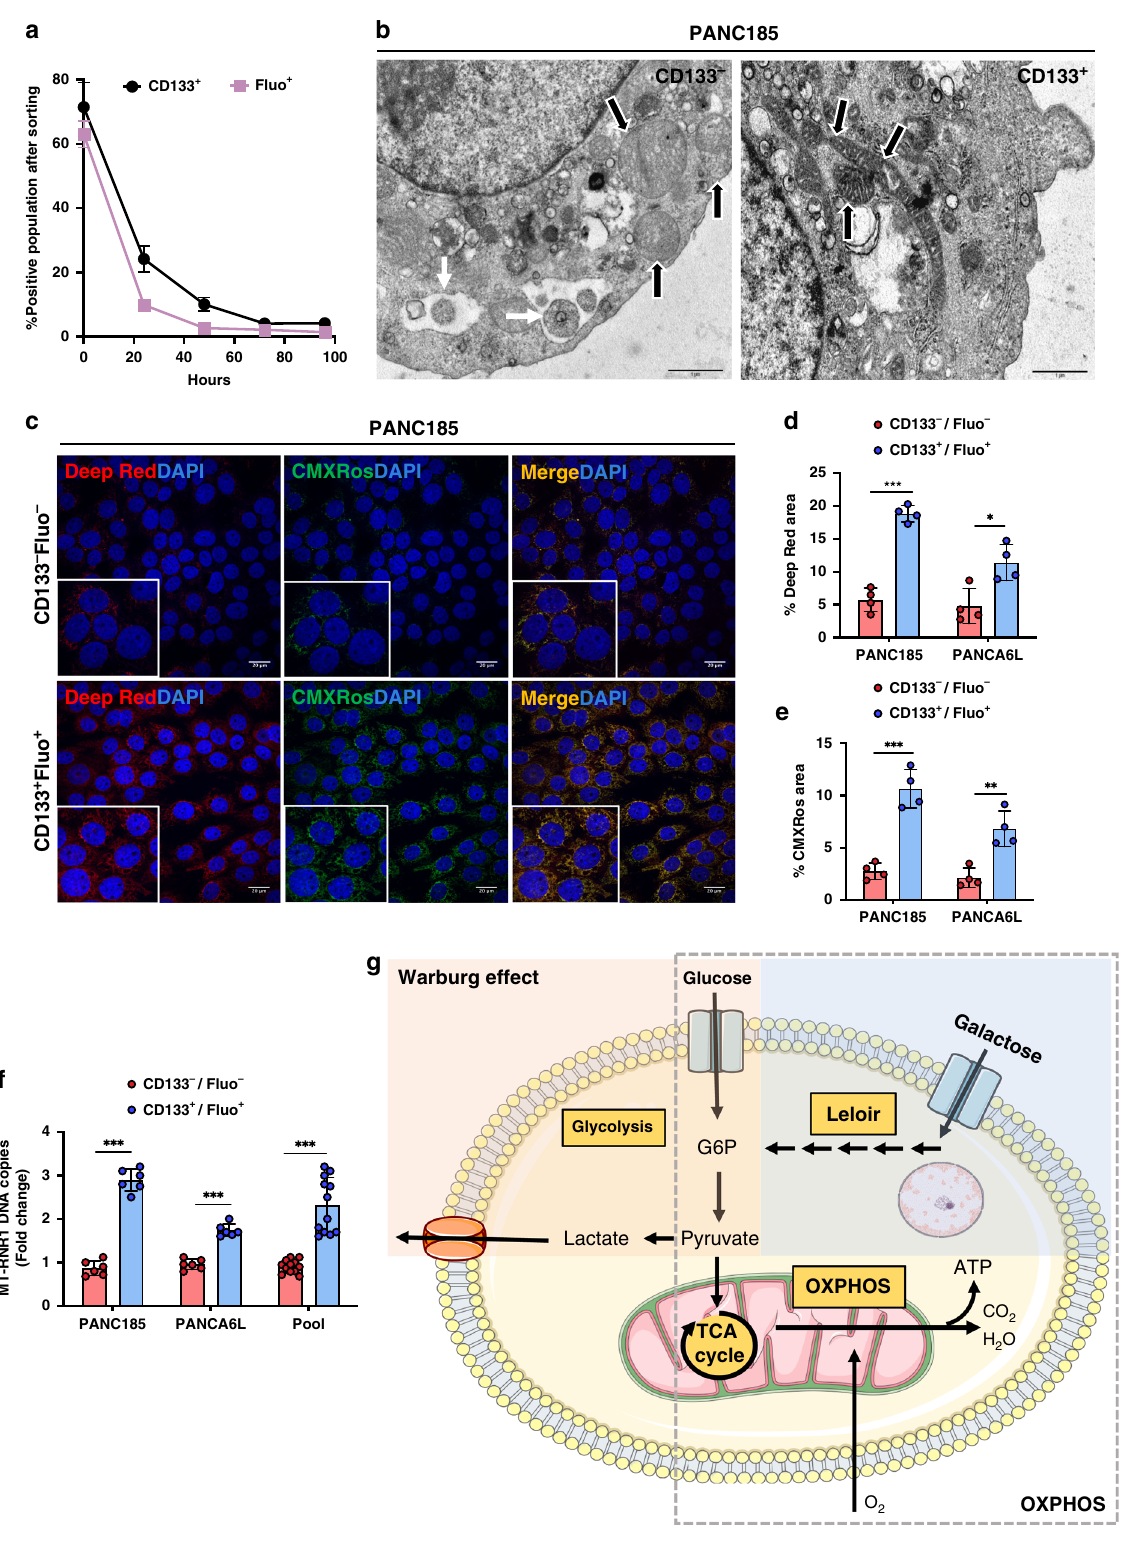
sphere versus adherent cultures (Supplementary Fig. 1g). Lastly, long-term PaCSC-enriched Gal-CC could be established directly from a freshly resected patient-derived xenograft (PDX) tumor (Supplementary Fig. 1h, i), highlighting the translatability of these fi ndings and the putative applicability of this system to surgically resected patient